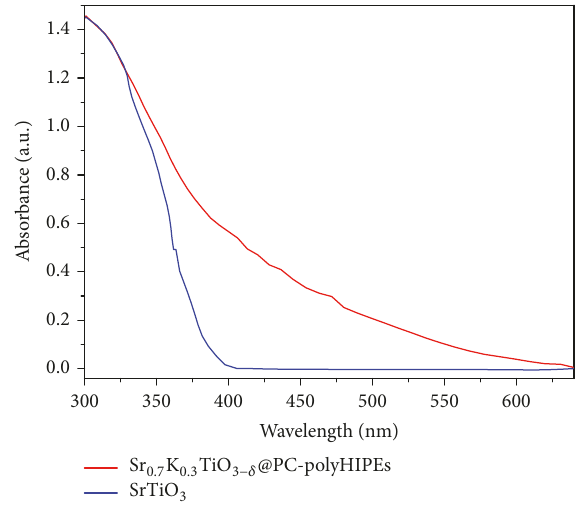
Figure 8: UV-Vis DRS spectra of Sr 0.7 K 0.3 TiO 3−𝛿 @PC-polyHIPEs and neat SrTiO 3